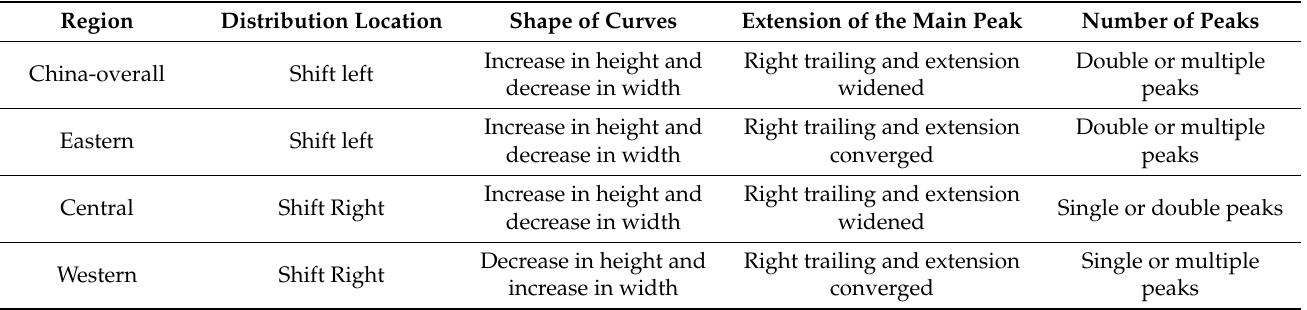
Table 4. Characteristics of the dynamic distribution of the livelihood resilience of rural residents in